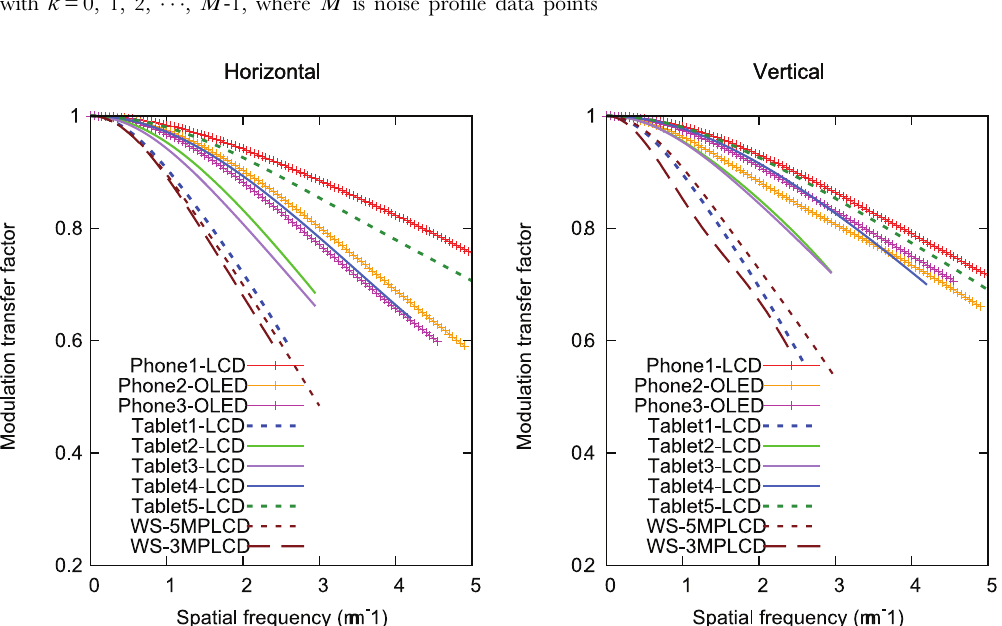
Figure 5. Modulation transfer functions as a function of absolute spatial frequency for the devices tested in this study.